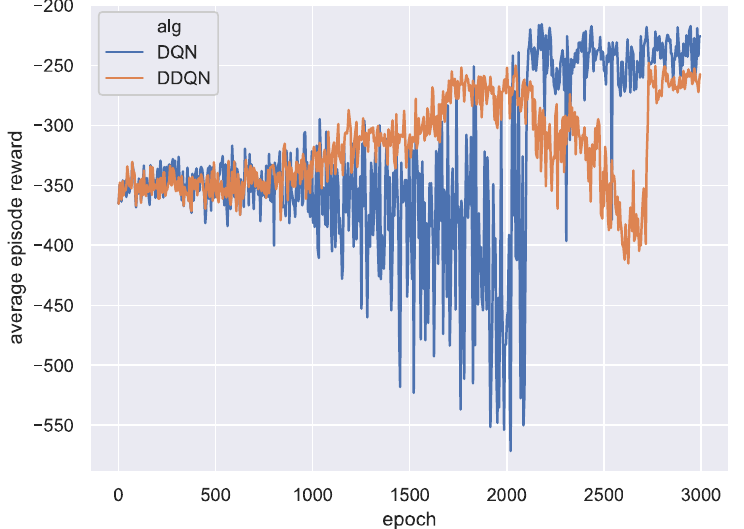
Figure 6. Average episode reward on all test instances at each training epoch for DQN and DDQN.